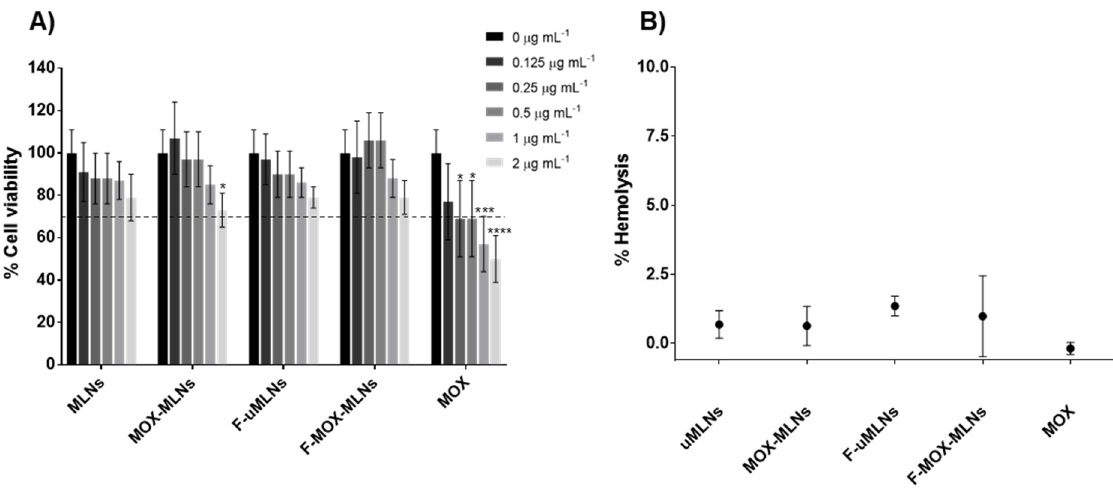
Figure 3. In vitro cytocompatibility studies. ( A ) MTT using the fibroblast L929 cell line. In this assay, different concentrations of encapsulated and free MOX were assessed (2.0, 1.0, 0.5, 0.25, and 0.125 µg mL − 1 ). Triton TM -100x (1%, v/v ) and DMEM were used as negative and positive controls, respectively. ( B ) Hemolysis assay. Encapsulated and free MOX at a concentration of 512 µg mL − 1 were tested. For negative and positive controls, saline solution (0.85%, w/v ) and Triton TM -100x (1%, v/v ) were used, respectively. All values are presented as mean ± SD. * p < 0.05, *** p < 0.001, **** p < 0.0001, relative to the positive control. Statistical analysis: two-way ANOVA, Dunnett’s multiple comparisons test.